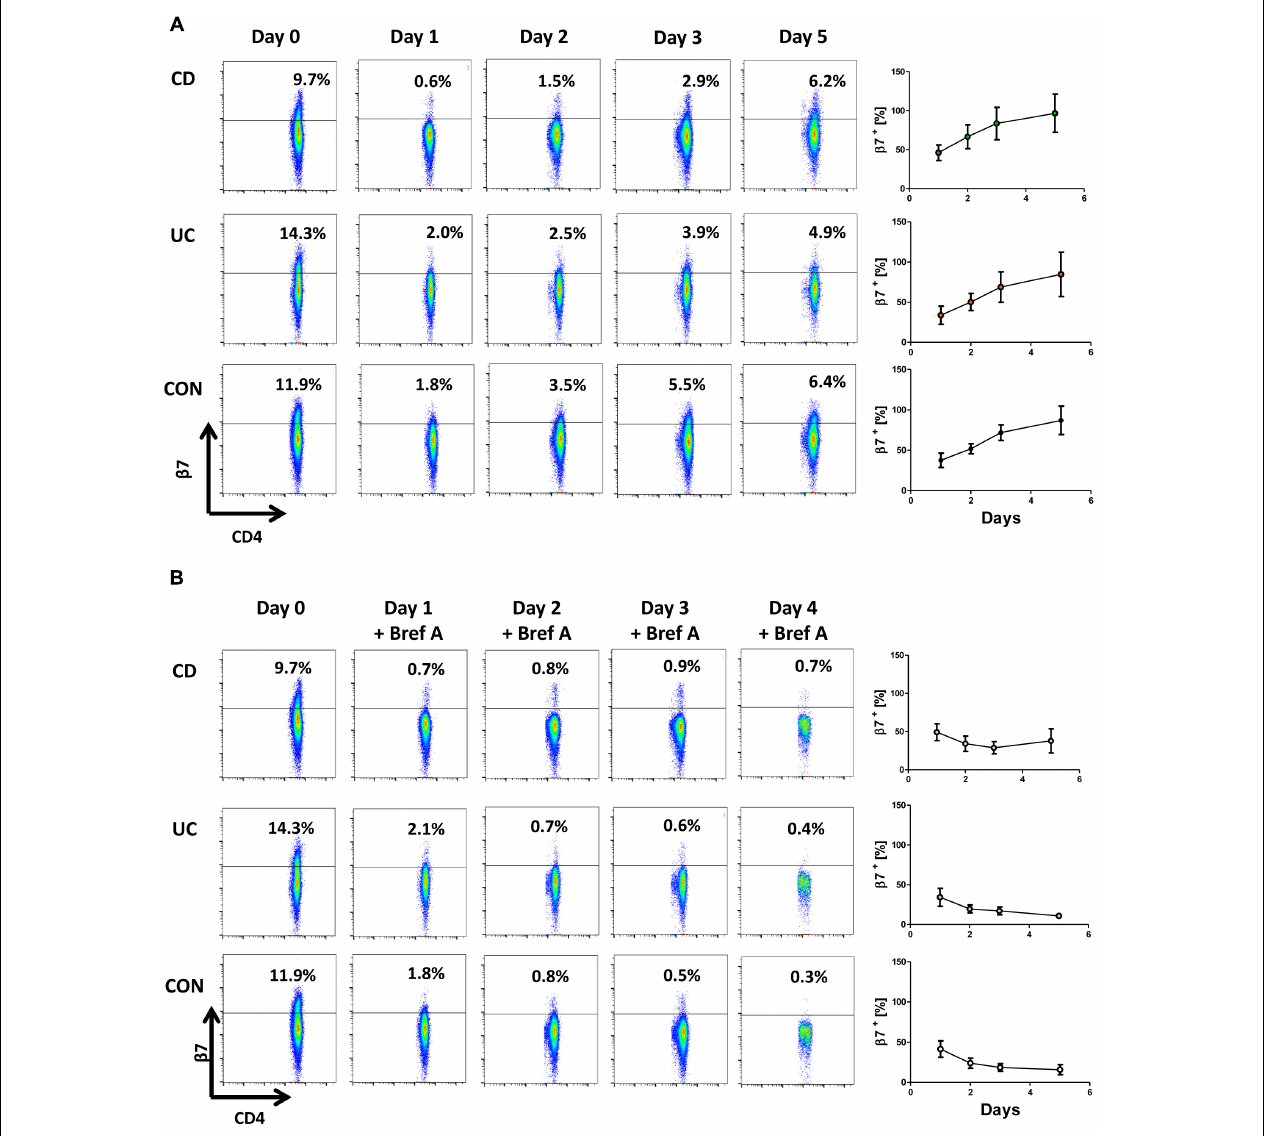
FIGURE 6 | Cell surface expression of β 7 integrin is restored after removal of etrolizumab-s. (A) Left panels: Representative flow cytometry showing β 7 integrin expression at baseline (day 0) and 24 (day 1), 48 (day 2), 72 (day 3) and 120 h (day 5) after treatment with etrolizumab-s for the first 24 h of the experiment. Right panels: Quantitative flow cytometry of β 7 surface expression over time relative to day 0 ( n = 5–6 per group). (B) Left panels: Representative flow cytometry showing β 7 integrin expression at baseline (day 0), and 24 (day 1), 48 (day 2), 72 (day 3) and 120 h (day 5) after treatment with etrolizumab-s for the first 24 h of the experiment and treatment with Brefeldin A from day 1 to day 5. Right panels: Quantitative flow cytometry of β 7 surface expression over time relative to day 0 ( n = 5–6 per